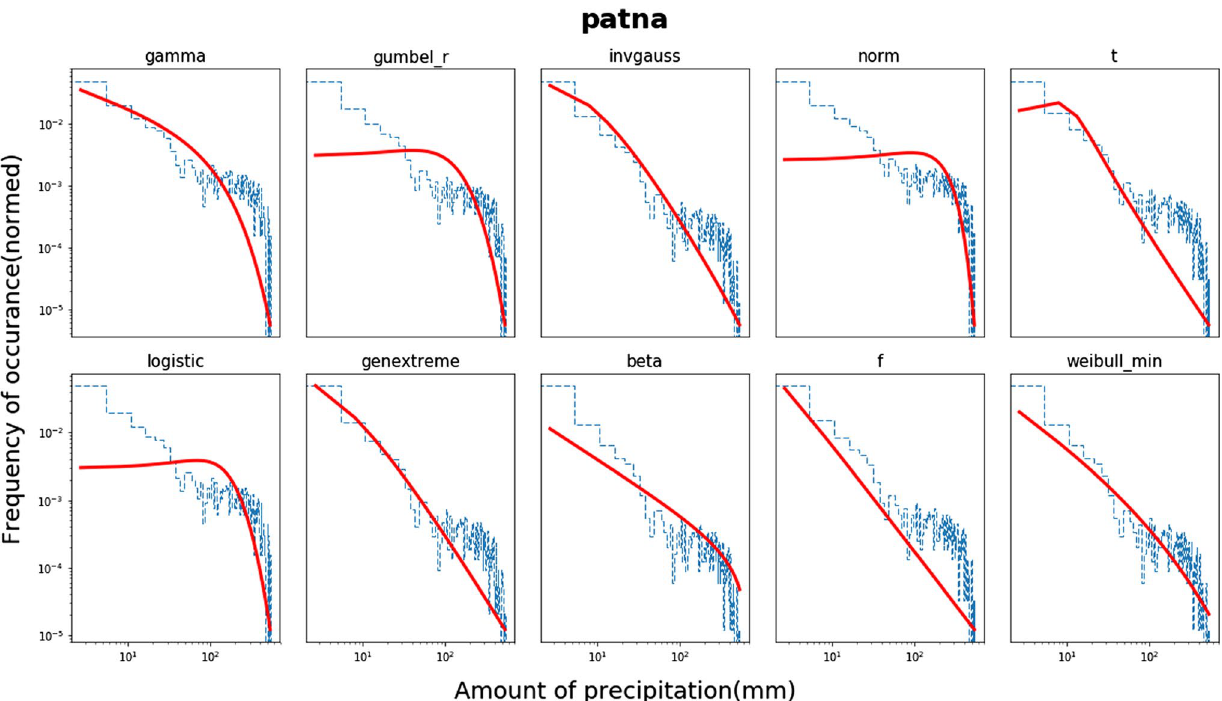
Fig. 5 Histogram of the monthly precipitate data at Patna (blue lines) along with best fit for each of the 10 probability distributions functions considered Table 3 Station-wise best ranked probability distribution using differ- ent goodness-of-fit tests